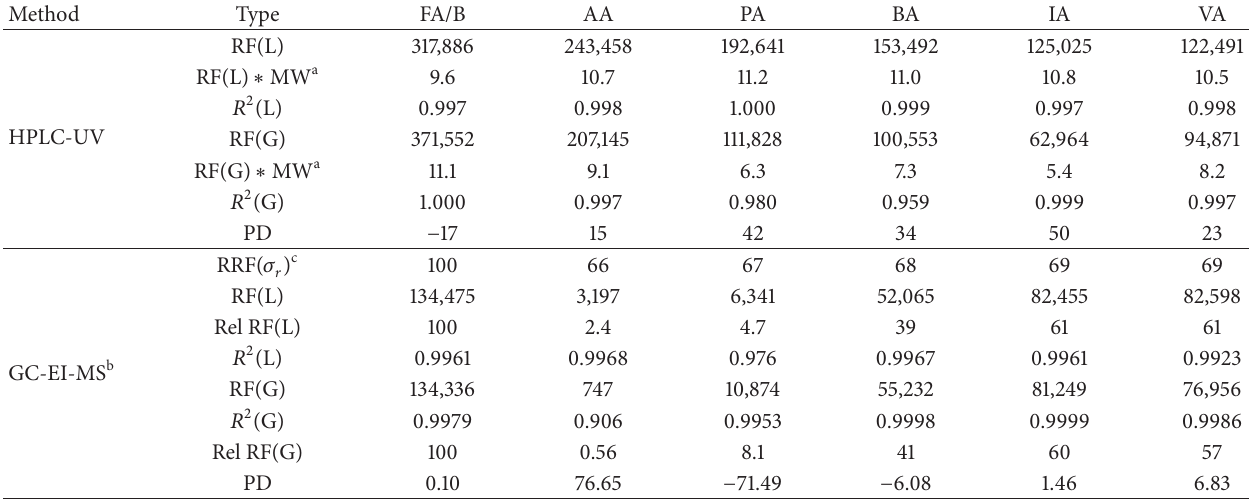
Table 4: Comparison of relative recovery of each CC between different standard phases for a given method. Method